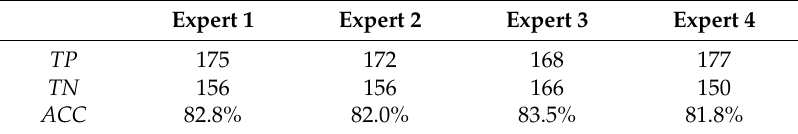
Table 1. The accuracy ACC of recognitions provided by particular experts.